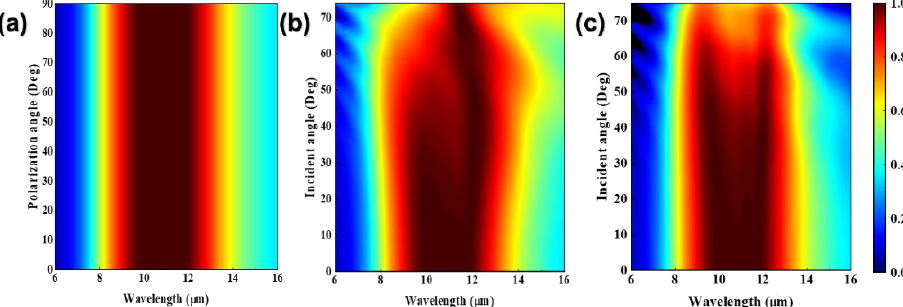
Figure 8. ( a ) Absorption spectrum under different polarization angles. ( b ) Absorption spectrum under different incident angles (TE wave). ( c ) Absorption spectrum under different incident angles (TM wave).